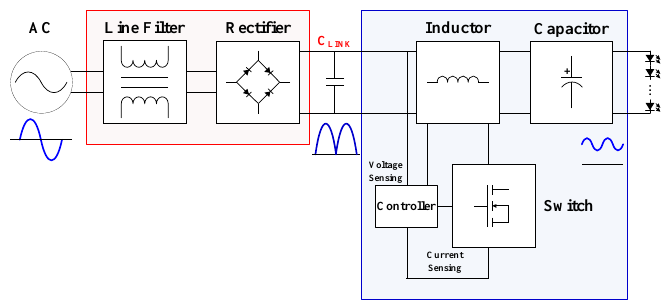
Figure 1. The block diagram of typical single-stage buck-boost light-emitting diode (LED) con- verter.